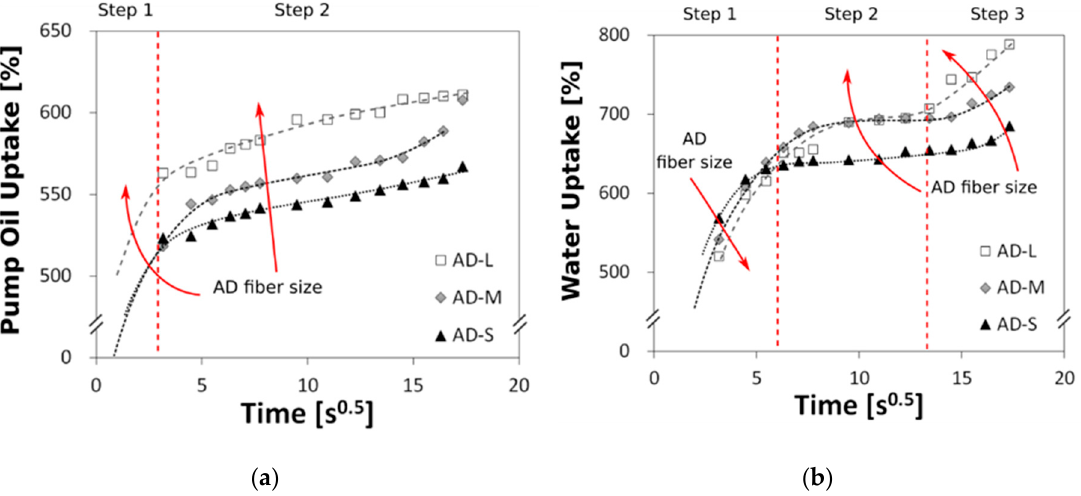
Figure 4. Sorption capacity at increasing sorption time in ( a ) water and ( b ) pump oil of AF-L, AF-M, and AF-S samples.